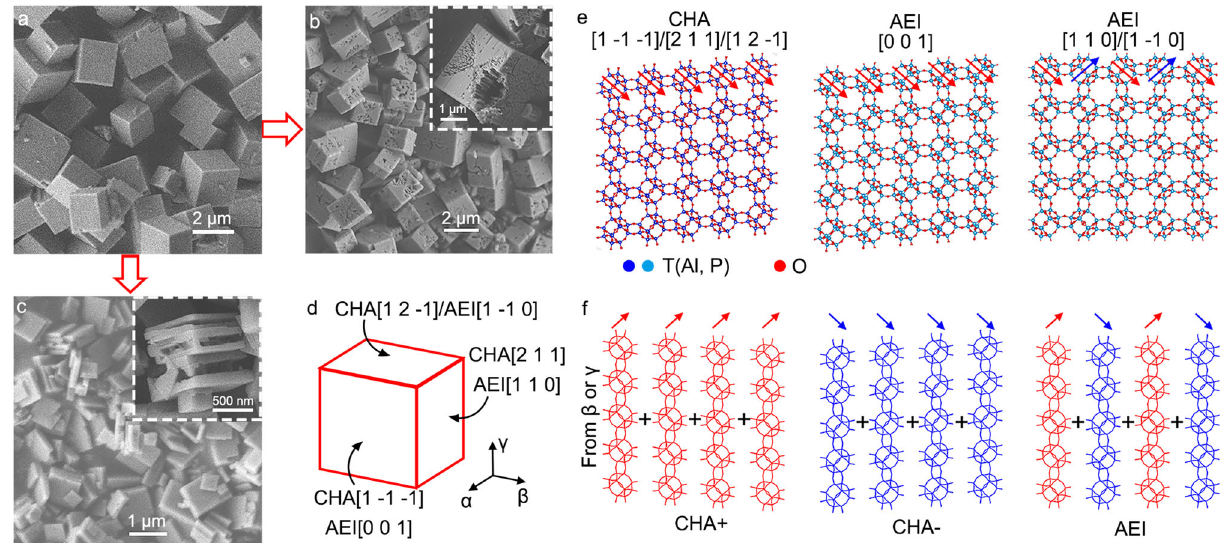
Fig. 1 SAPO-34/18 intergrowth catalysts. a SEM image showing the traditional micron-sized cuboid architectures of SAPO-34/18 catalysts. b , c SEM images of the modi fi ed SAPO-34/18 intergrowth catalysts with hierarchical ( b ) and sandwich ( c ) architectures. d Cuboid model showing the crystallographic axes of SAPO-34 (CHA) and SAPO-18 (AEI) in the intergrowth crystals. e Structural model of the CHA and AEI frameworks viewed from the different crystallographic axes given in ( d ). f Layer-based model of CHA and AEI frameworks viewed from direction β or γ Figure 6, the [0 0 1] projection of SAPO-18 (AEI) highly matches